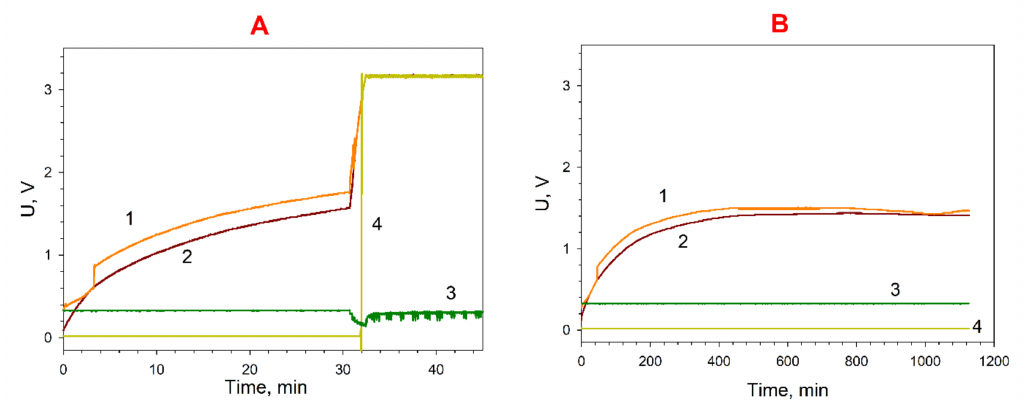
Figure 6. Diagrams of electric energy accumulation by a 6800- µ F capacitor from two MFC models during wastewater treatment: 1, charge voltage; 2, voltage across the accumulating capacitance; 3, input voltage coming to the converter; 4, voltage signalling that the set charge level has been reached. ( A ), the first 24 h; ( B ), after 96